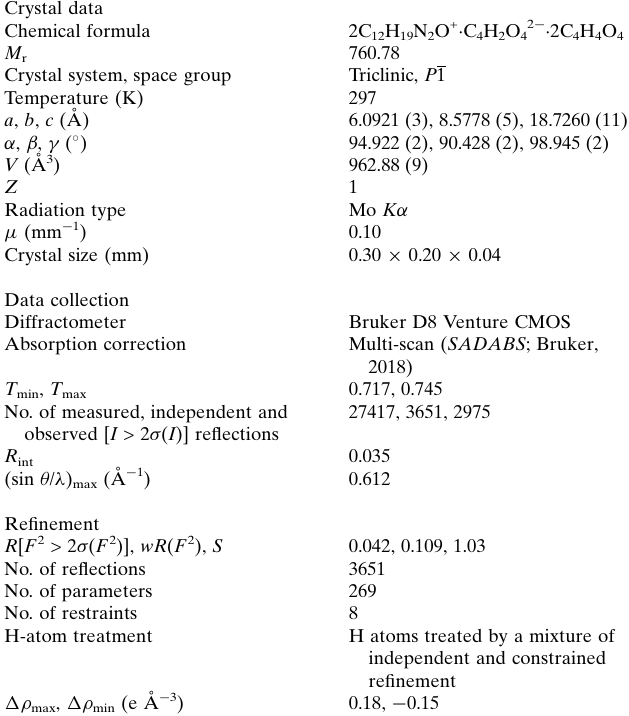
Crystal data Chemical